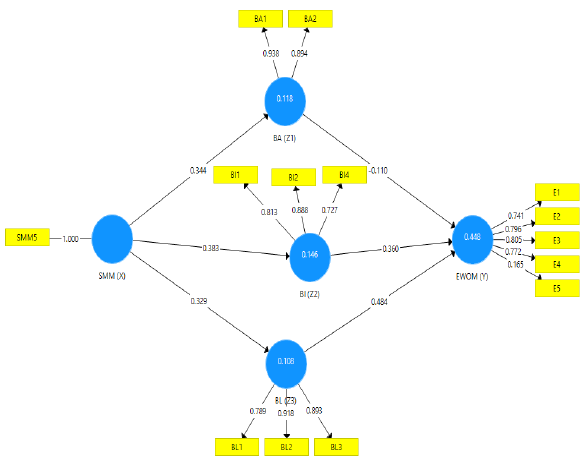
Fig. 5. Structural Model Testing Results